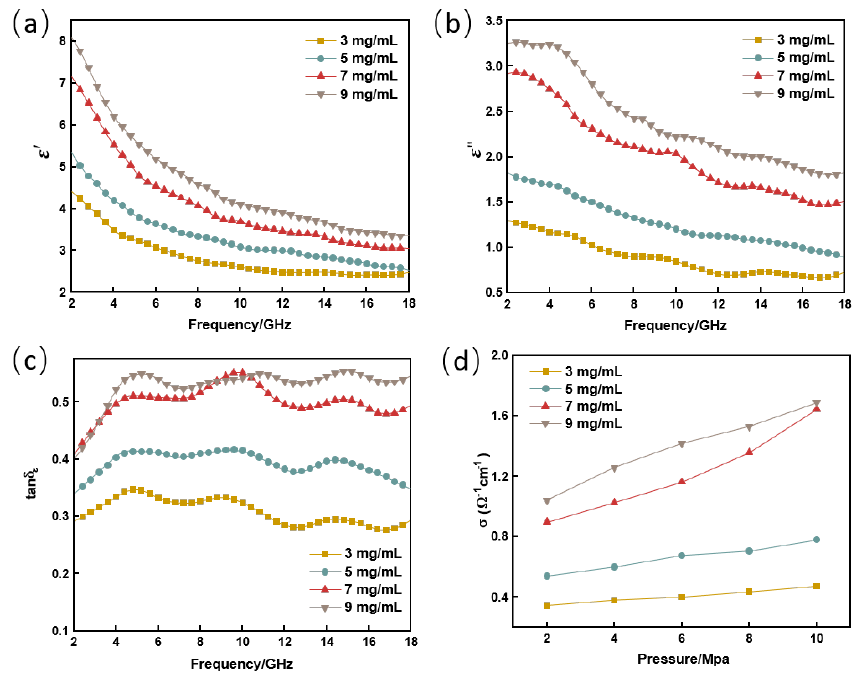
Figure 4. Electromagnetic parameters of the RGO/NW composite: ( a ) real part of the dielectric constant ε (cid:48) ; ( b ) imaginary part of the dielectric constant ε (cid:48)(cid:48) ; ( c ) dielectric loss tangent value tan δ ε ; ( d ) electrical conductivity σ